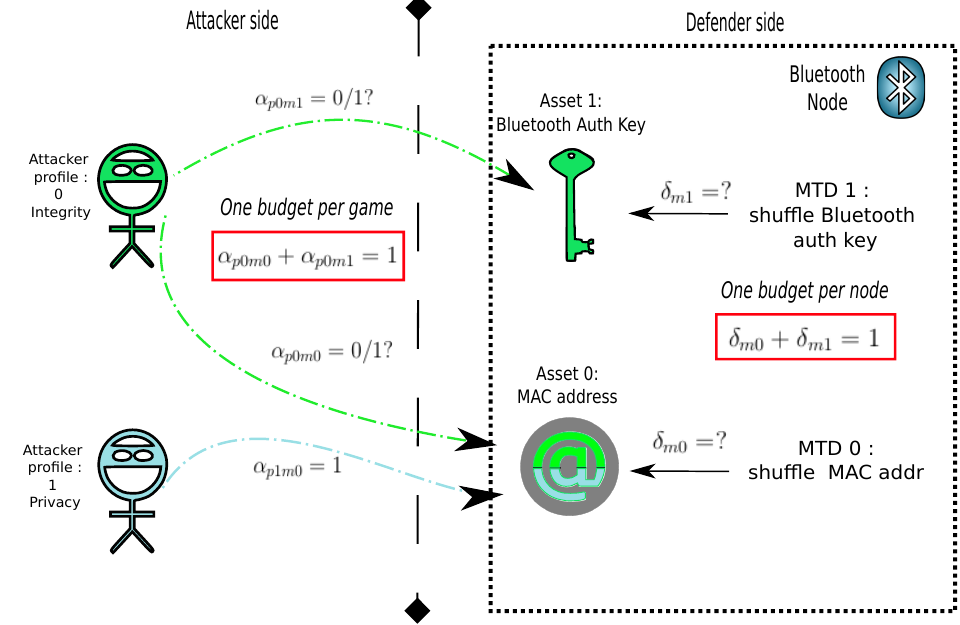
Figure 2. Model representation for 1 node and 2 attacker